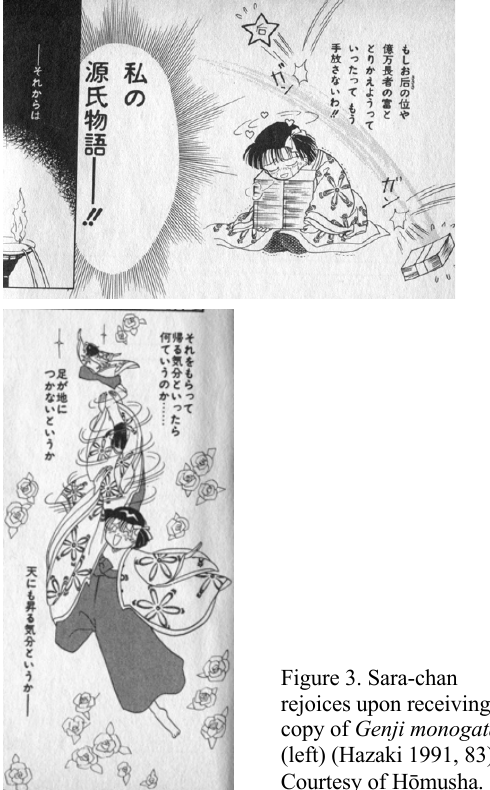
Figure 3. Sara-chan rejoices upon receiving a copy of Genji monogatati (left) (Hazaki 1991, 83). Courtesy of